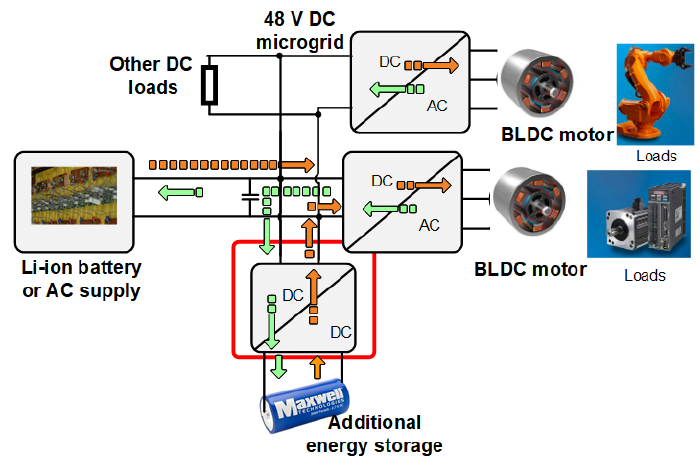
Figure 1. Supercapacitor energy storage integration into a 48 V DC microgrid.